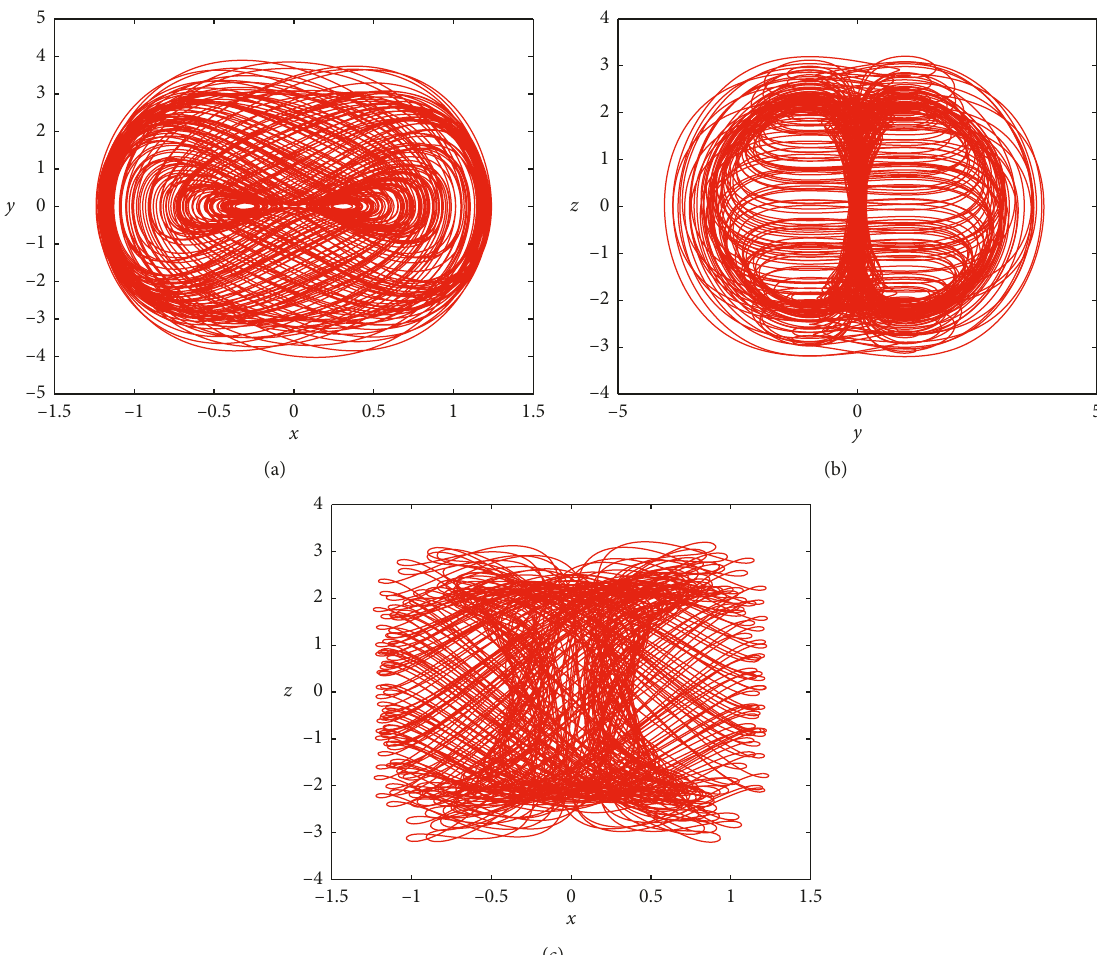
Figure 1: Phase portrait projected onto the plane of (a) x – y ; (b) y – z ; (c) x – z .